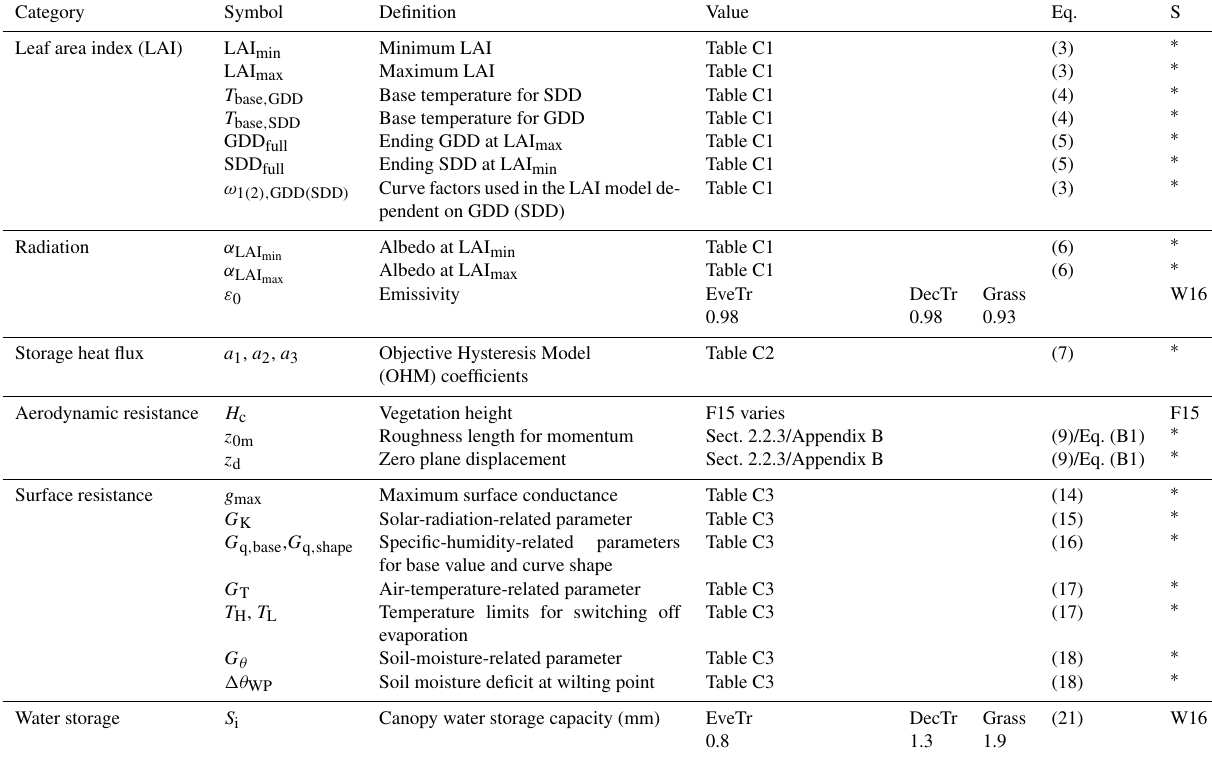
Table 1. Parameters and the first process they are used in by SUEWS (i.e. most impact multiple variables). Sources (S) include this study ( ∗ ), Ward et al. (2016) (W16) and FLUXNET2015 (F15, Pastorello et al., 2020) where values are given or used in individual equations (Eq.). Two key phenology periods are related to growing and senescence degree days (GDD,